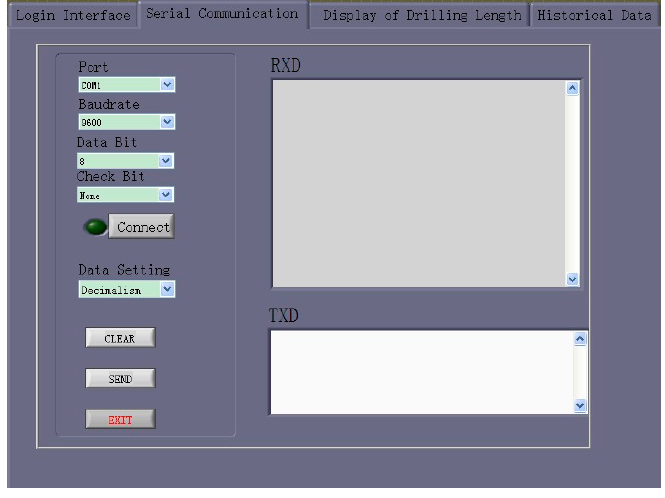
Figure 10. Serial-communication interface of the visual drilling-length management software.